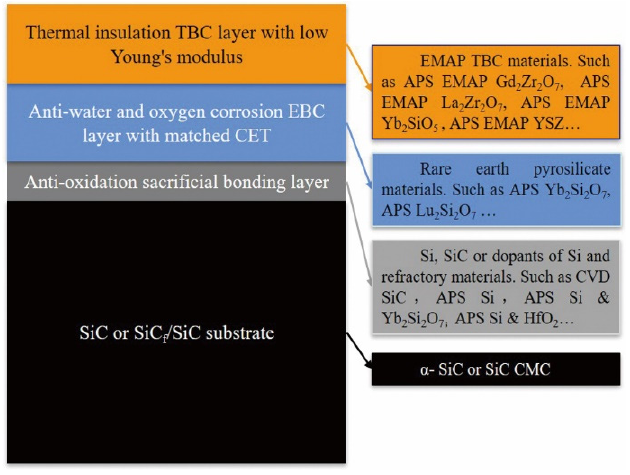
Figure 8. Three-layer coating design of EMAP T/EBCs coating system.